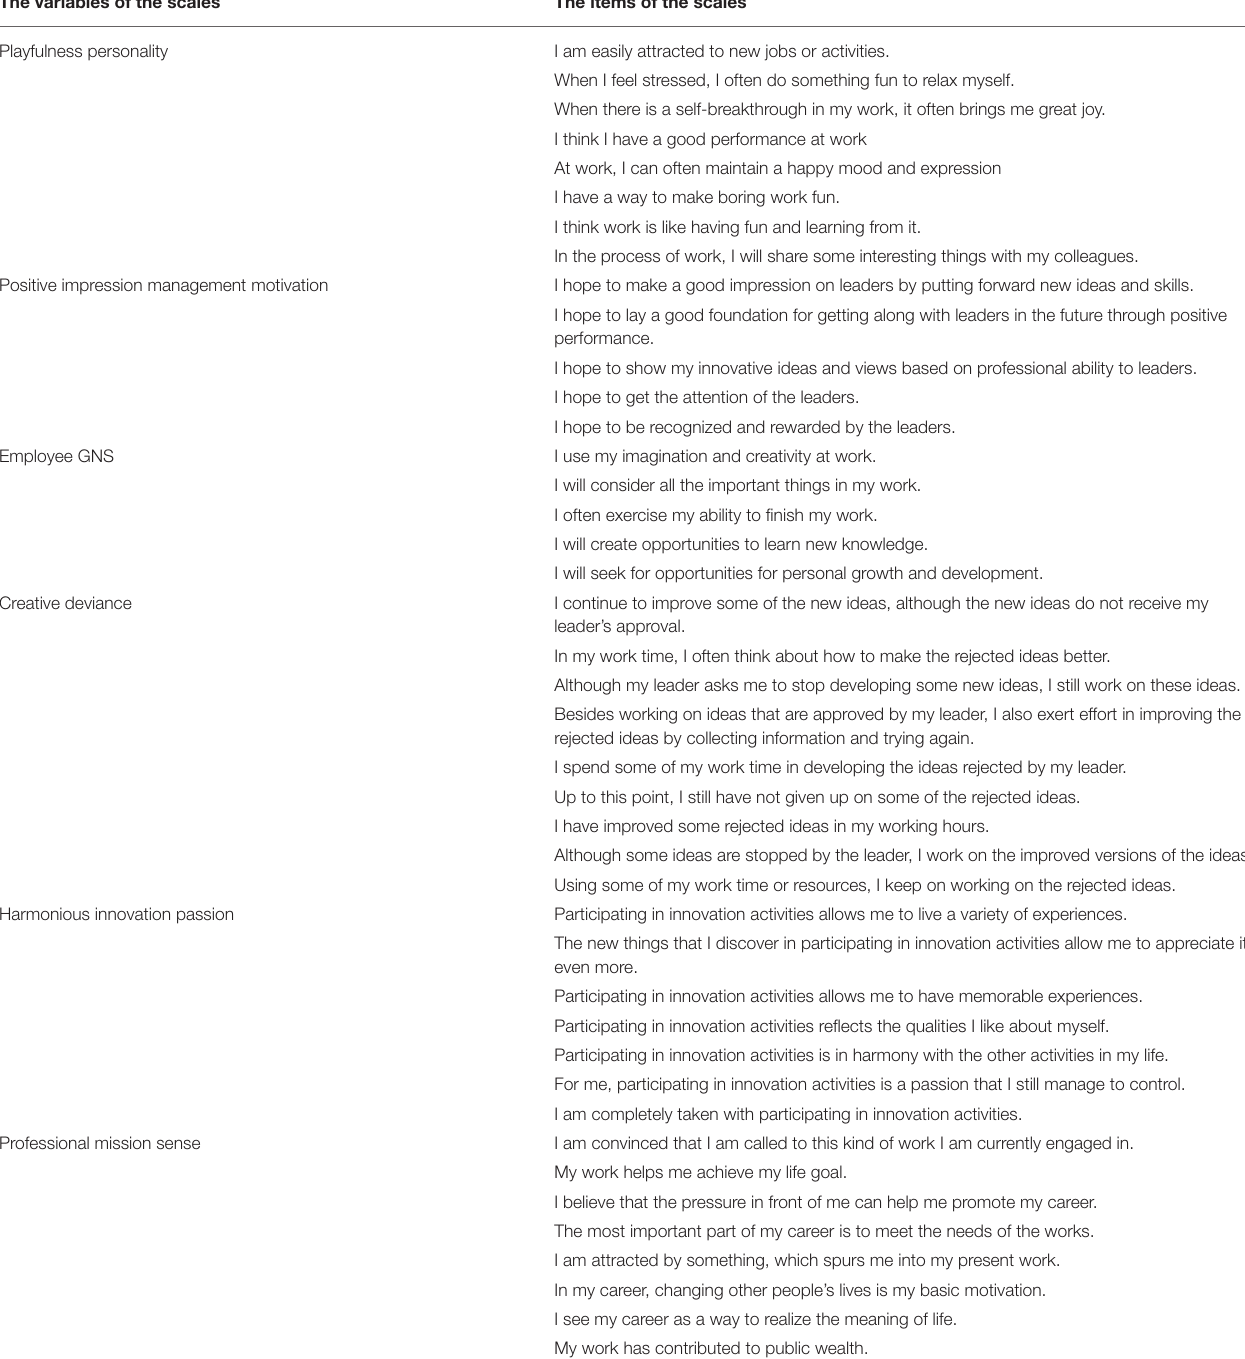
TABLE 3 | The scales and the corresponding items. The variables of the scales The items of the scales Playfulness